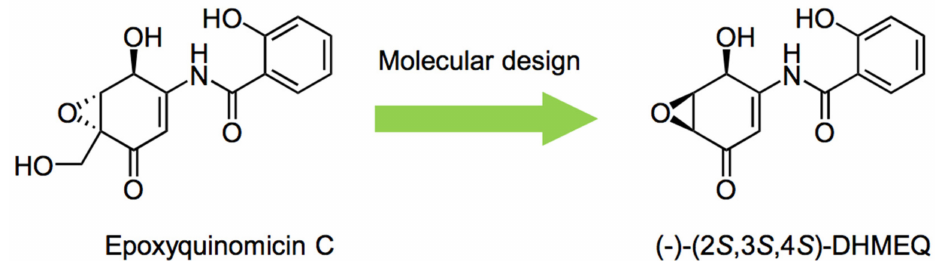
Figure 1. Molecular design of DHMEQ based on an antibiotic epoxyquinomicin